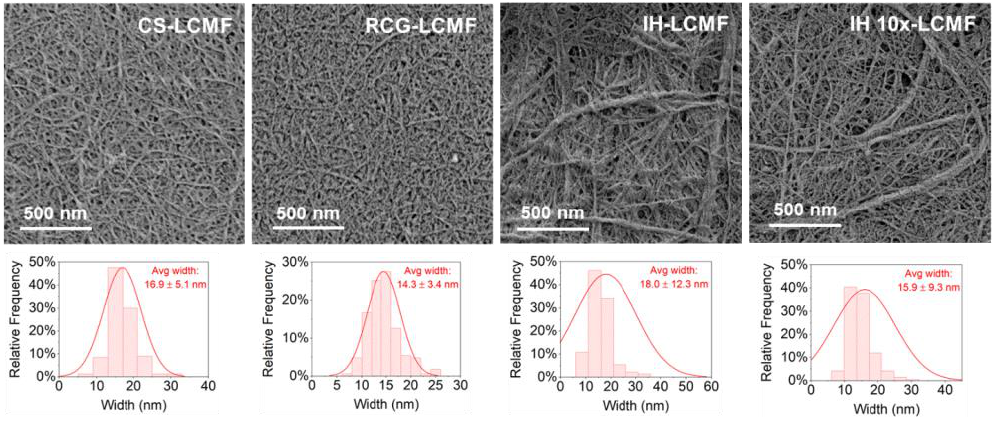
Figure 7. SEM images and size distribution curves of LCMF from different biomass feedstocks.